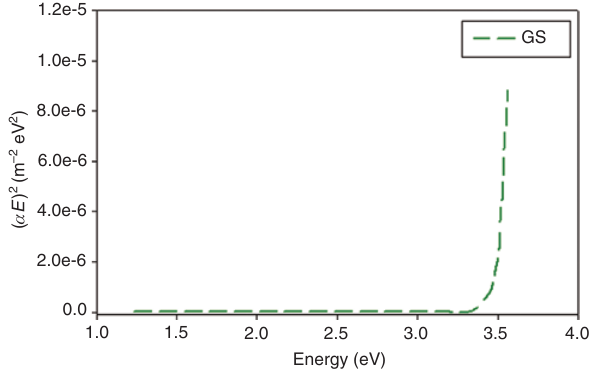
Figure 7: ( α E ) 2 versus photon energy (eV) for zinc oxide nanoparti- cles (ZnO-NPs)